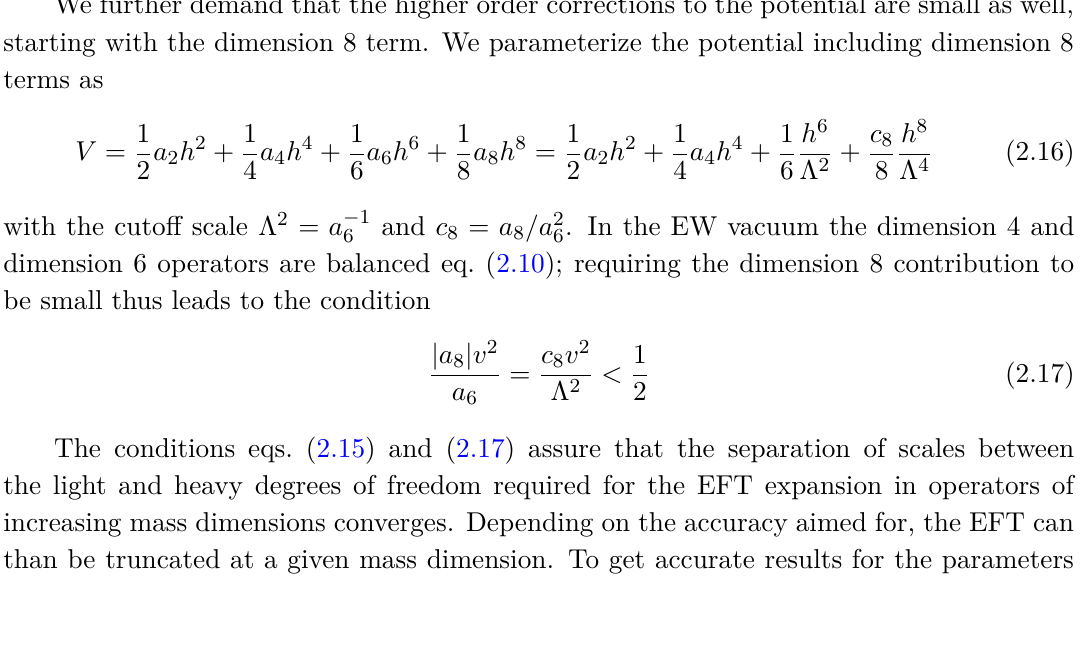
Figure 1. The strength of the first order phase transtion R N = v N SMEFT (left plot) and for a dark Higgs mass of m the SM (right plot). The red line corresponds to the SMEFT truncated at dimension 6, which is a good approximation only when the dimension 8 operator is negligible. In the white region there is no cosmological first order phase transition to the electroweak